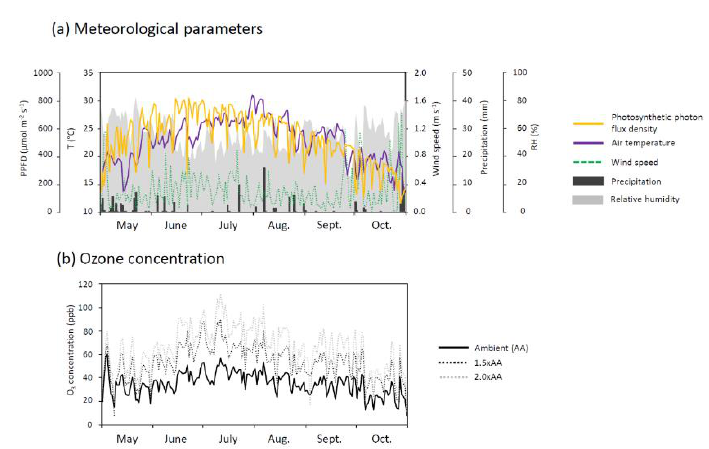
Figure 1. Meteorological factors and O 3 concentration over the experimental period (from May to October 2018) showing daily mean values of photosynthetic photon flux density (PPFD), air temperature (T), wind speed, precipitation, relative humidity (RH), and the following three levels of ozone concentrations at the O 3 FACE: Ambient air (AA), 1.5 times ambient O 3 concentration (1.5 × AA), and twice ambient O 3 concentration (2.0 × AA).